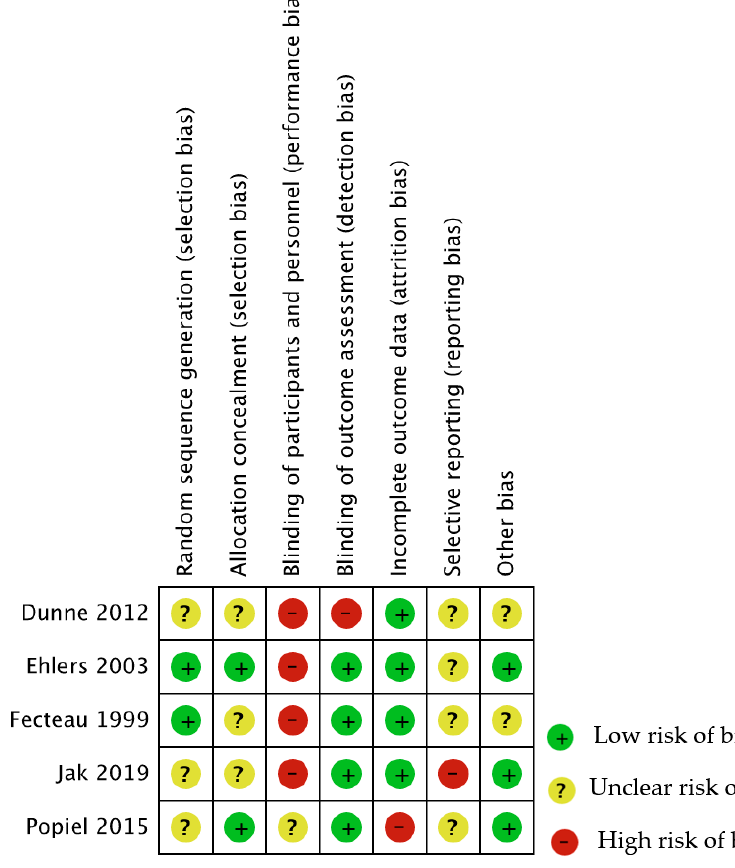
Figure 2. Risk of bias summary [26–30].